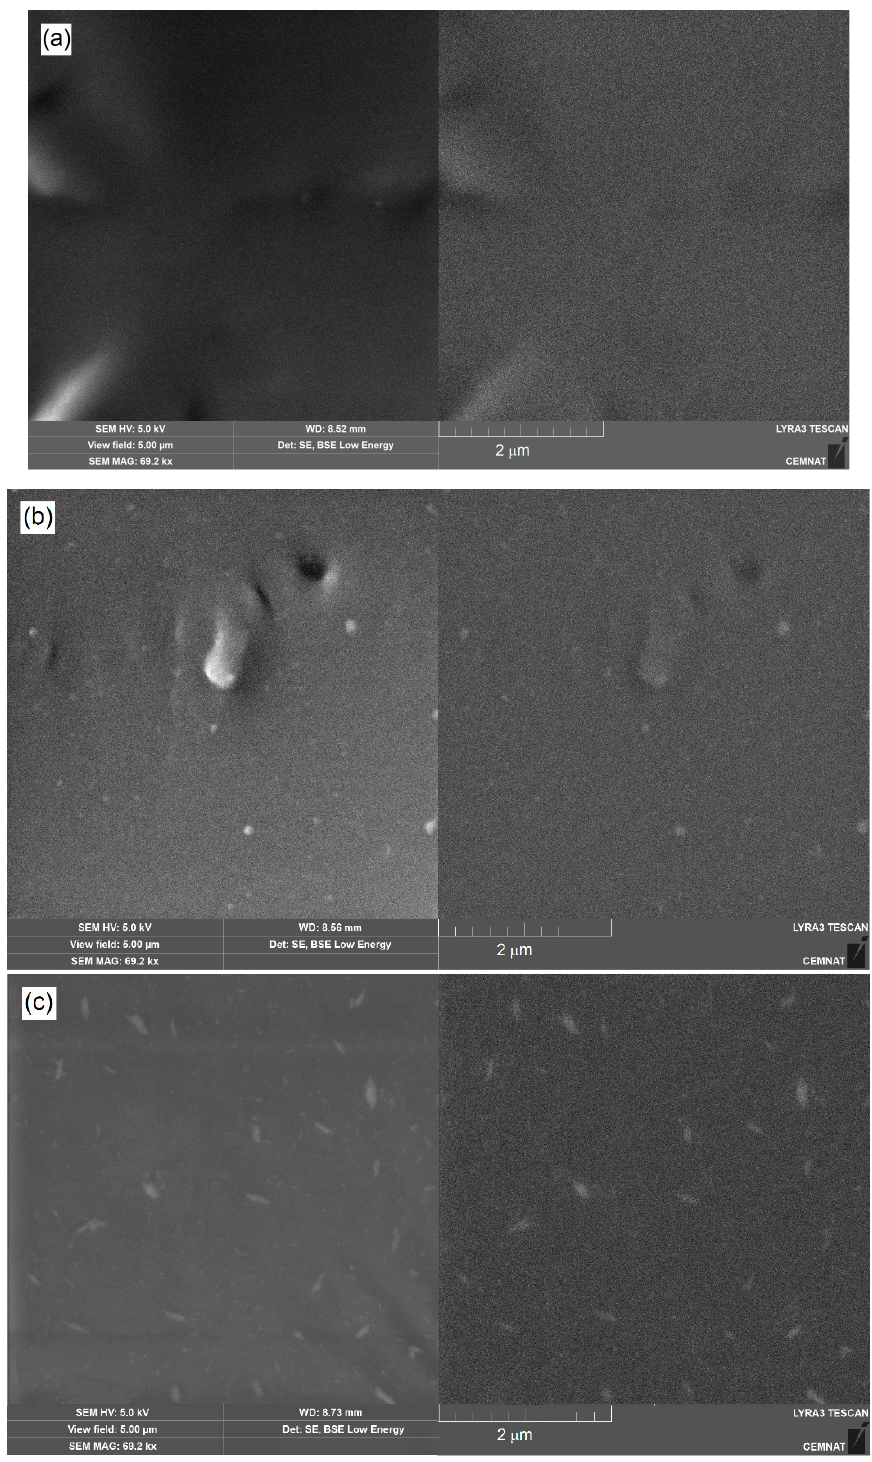
Figure 3. SEM images of cryo-fractures of coating samples taken in SE mode (left) and BSE mode (right): ( a ) sample L 0 without nanoparticles; ( b ) sample L ZnO-2.0 containing ZnO-based nanoparticles; ( c ) sample L MgO-2.0 containing MgO-based nanoparticles.